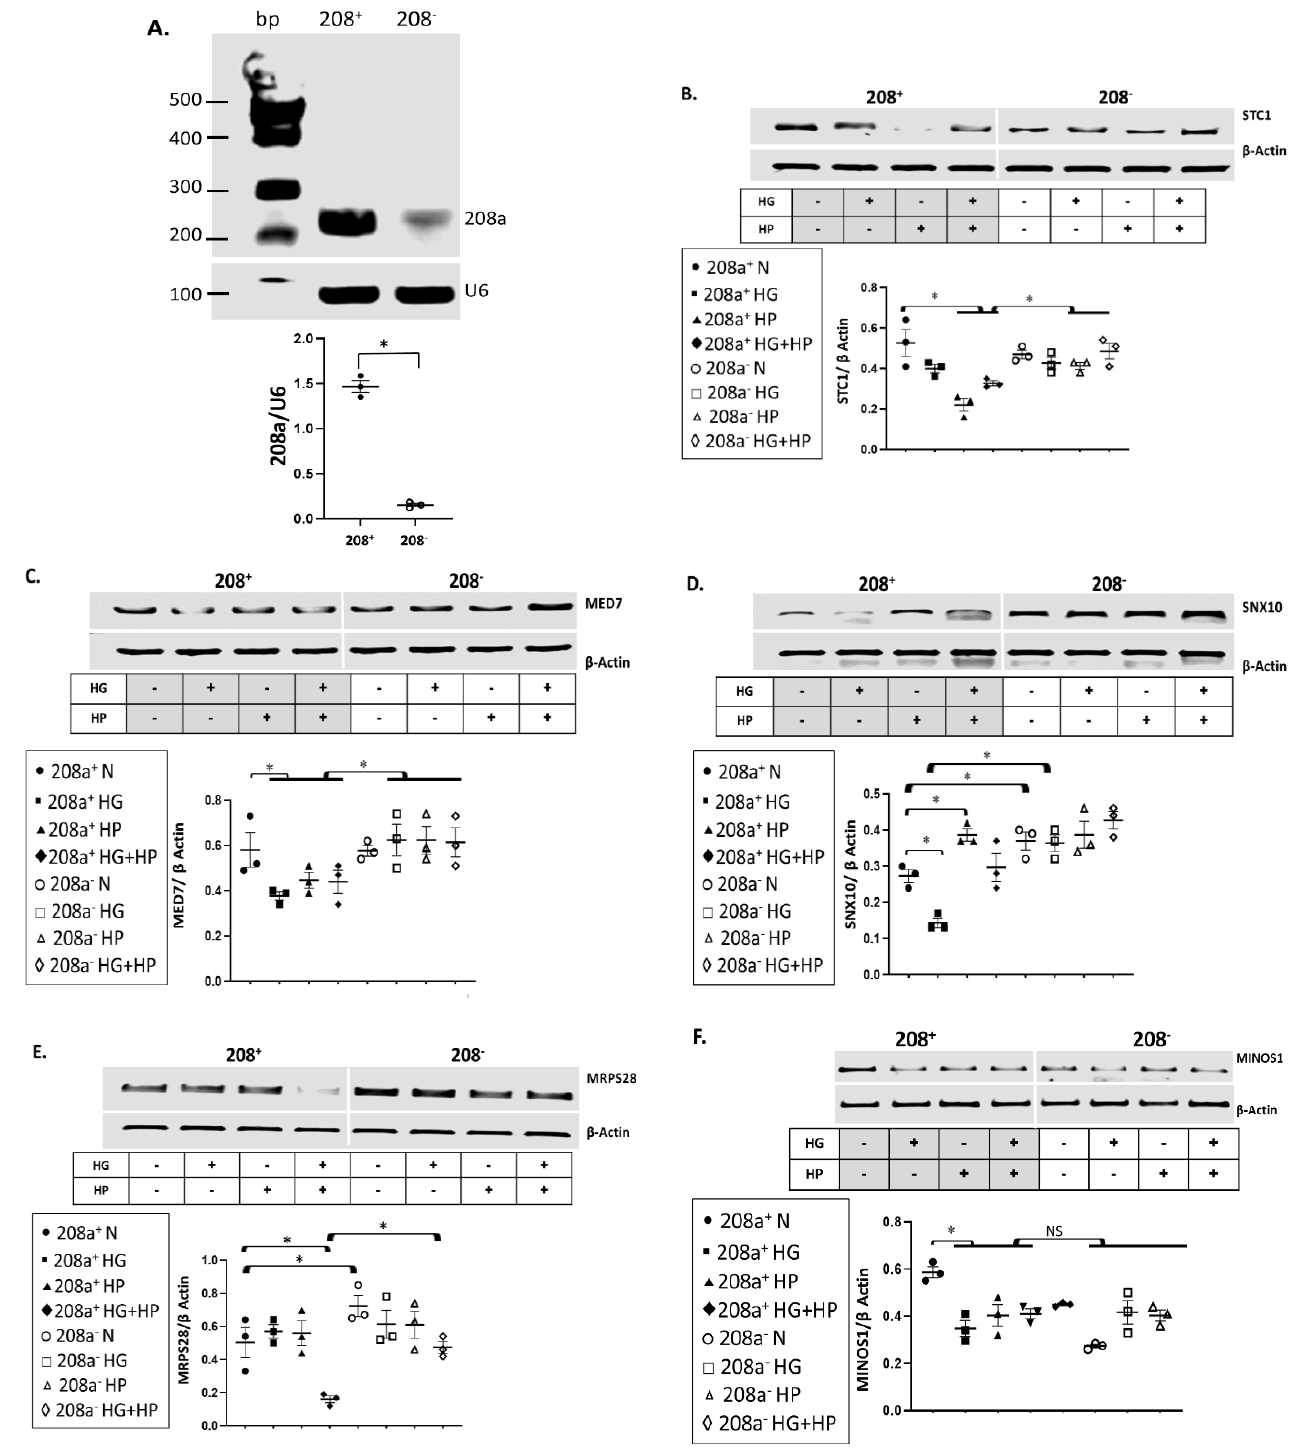
Figure 2. mRNA targets of miR 208a in cardiomyocytes incubated in diabetogenic conditions. ( A ) SV40 cardiomyocytes with normal (208 + ) and deficient (208 − ) miR 208a. First, 2 µ g of total RNA from each sample was used to generate cDNA. RT-PCR cDNA products were used as templates for quantitative PCR (qPCR). All the qPCR assays were run in duplicate. RT-PCR products were separated on 1.5% agarose gels, while the bands were quantified and expressed relatively to the housekeeping mRNA U6. A Quick-Load ® 100 bp DNA Ladder was used as a molecular weight marker. ( B ) Stanniocalcin 1 (STC1). ( C ) Mediator complex subunit 7 (MED7). ( D ) Sortin nexin 10 (SNX10). ( E ) Mitochondrial ribosomal protein S28 (MRPS28). ( F ) Mitochondrial contact site and cristae organizing system protein 1 (MINOS1). SV40 human cardiomyocytes were incubated in DMEM with 5 mM glucose (N), 25 mM glucose (high glucose, HG), or 20 µ M bovine serum